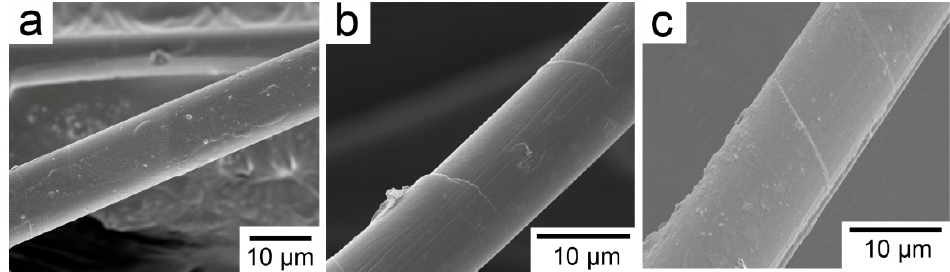
Figure 2. SEM photographs of ( a ) PBO-Pre fiber; ( b ) PBO-APTES fiber; ( c ) PBO-La fiber.